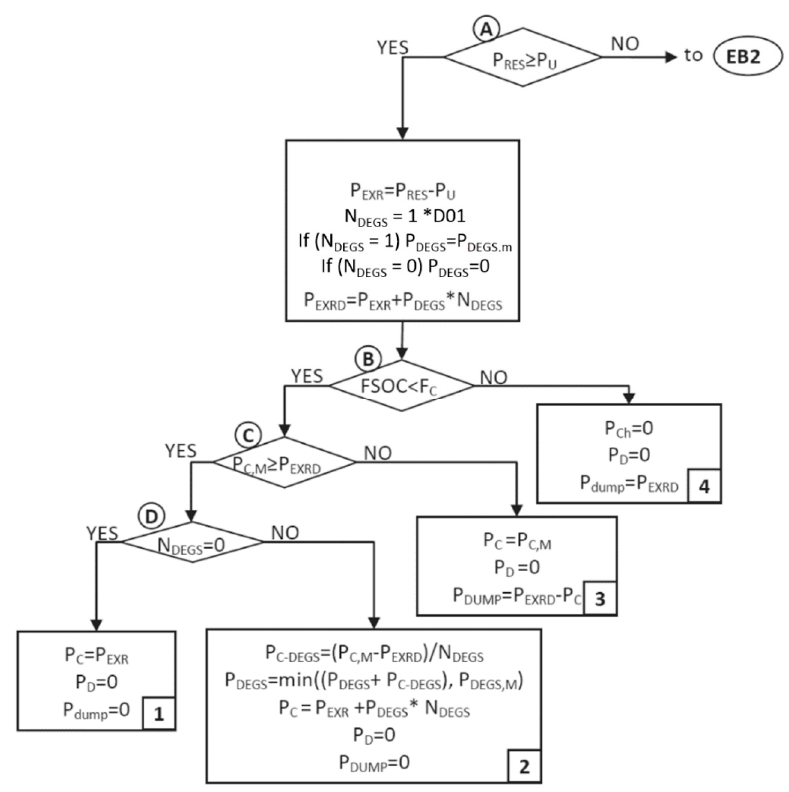
Figure 5. Control logic flow chart—evaluation block EB1.